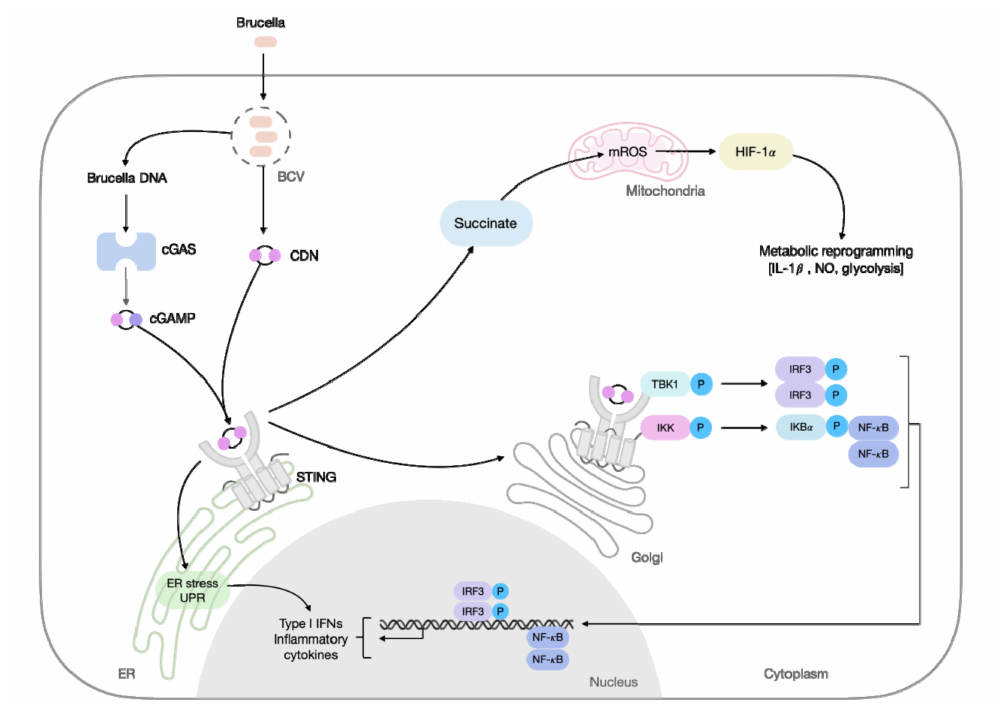
Figure 1. STING signaling in response to B. abortus infection. The intracellular bacteria, B. abortus , enters the host cell and forms the Brucella containing vacuole (BCV), to ensure survival. Upon the